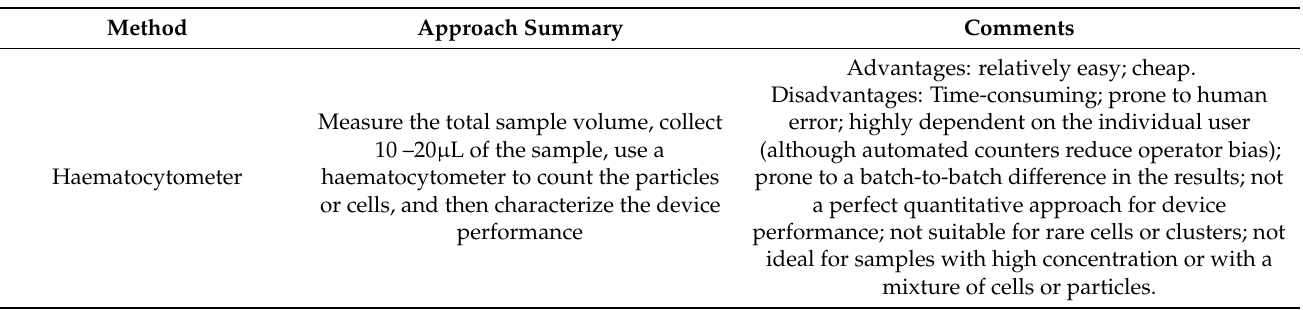
Table 2. A comparison of approaches used for evaluation of microfluidic devices utilized for particle and cell